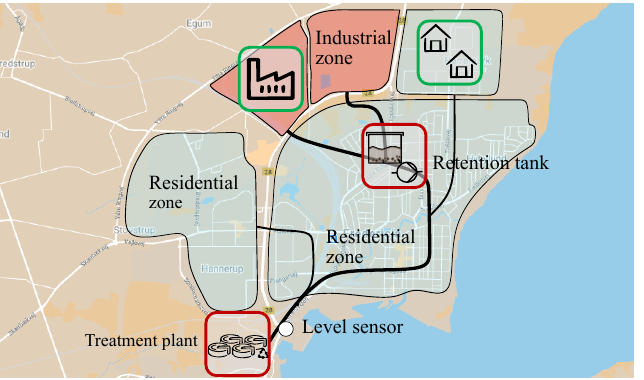
Figure 17. Map of Fredericia and its waste water collection scheme. Green and red blocks represent the main elements of the network which are emulated with laboratory